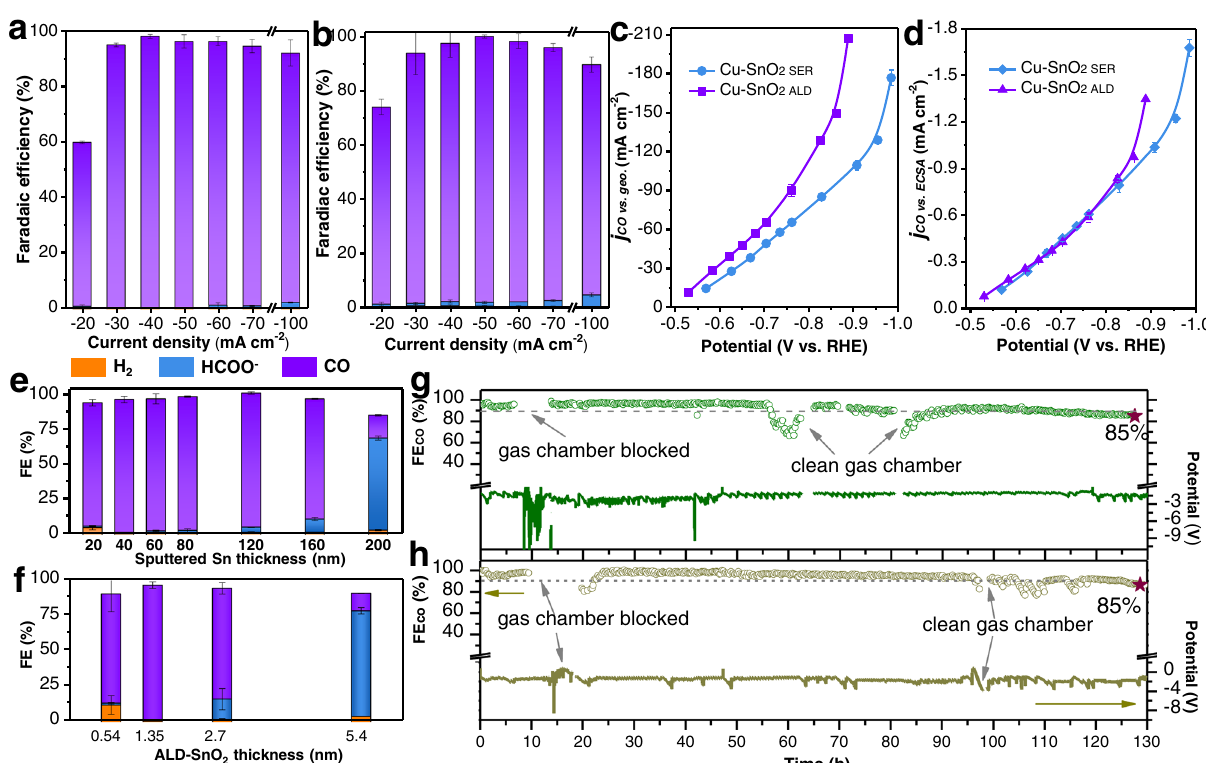
Fig.2|ElectrocatalyticperformanceofCu-SnO 2 catalysts. Faradaic ef fi ciencies of products generated on ( a ) Cu-SnO 2 ALD and ( b ) Cu-SnO 2 SER catalysts under different current densities. Partial current densities of CO normalized against ( c ) geometric surface area and ( d ) electrochemical surface active area of two catalysts. Faradaic ef fi ciencies of products produced on ( e ) Cu-SnO 2 SER and ( f ) Cu-SnO 2 ALD with different thickness of sputtered-Sn and ALD-SnO 2